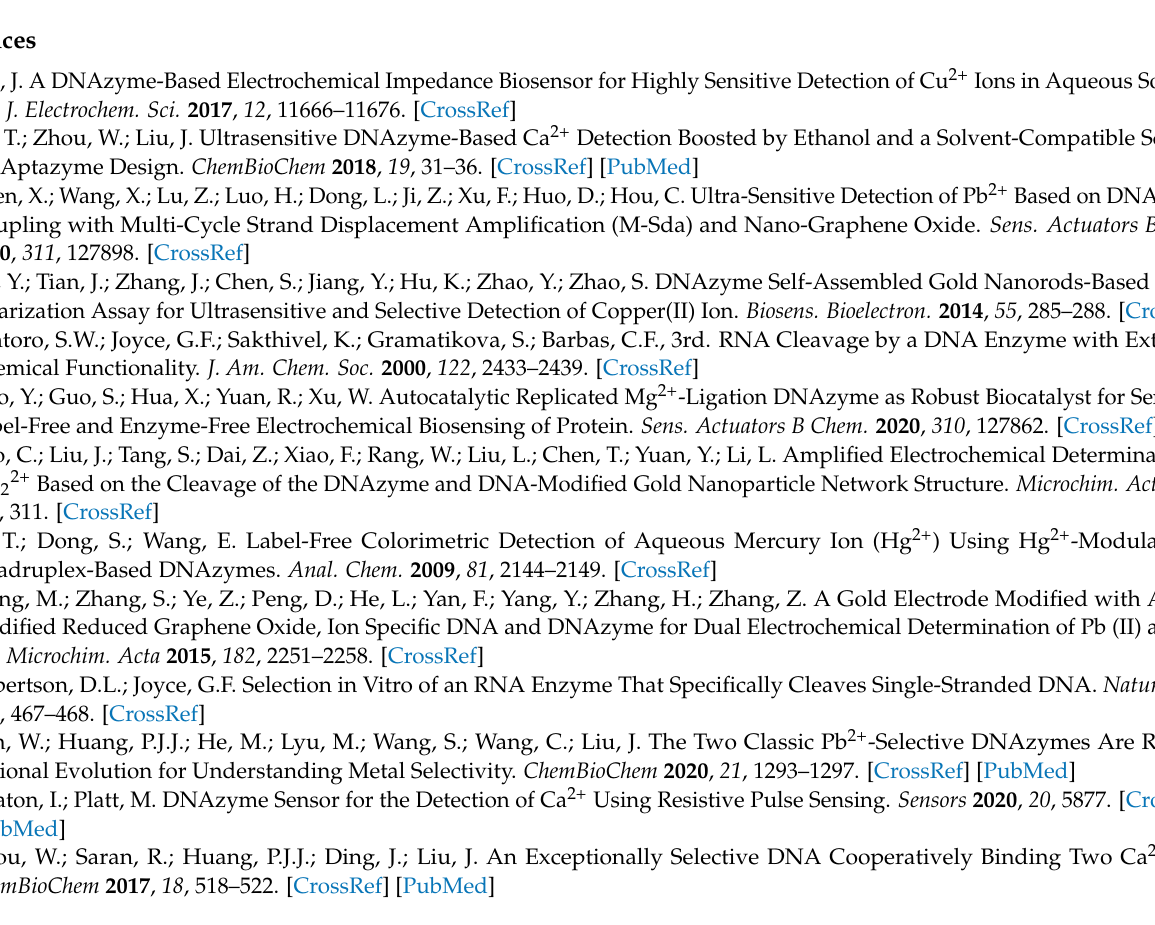
Figure S2: Comparison of the relative resistances of Ca 2+ at different concentrations with and without NGR